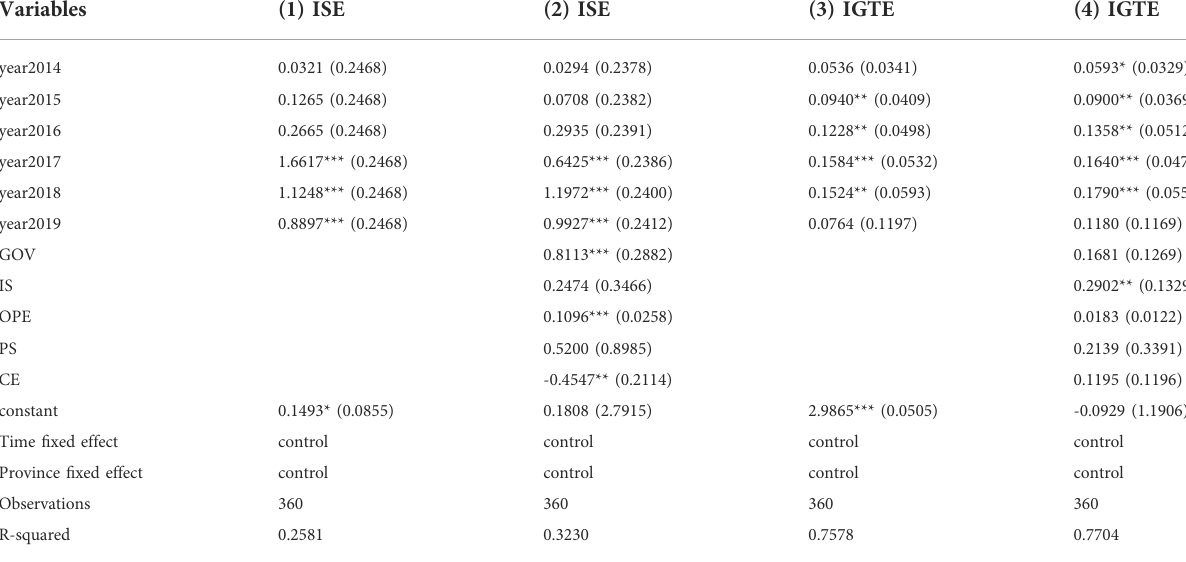
TABLE 3 Dynamic regression